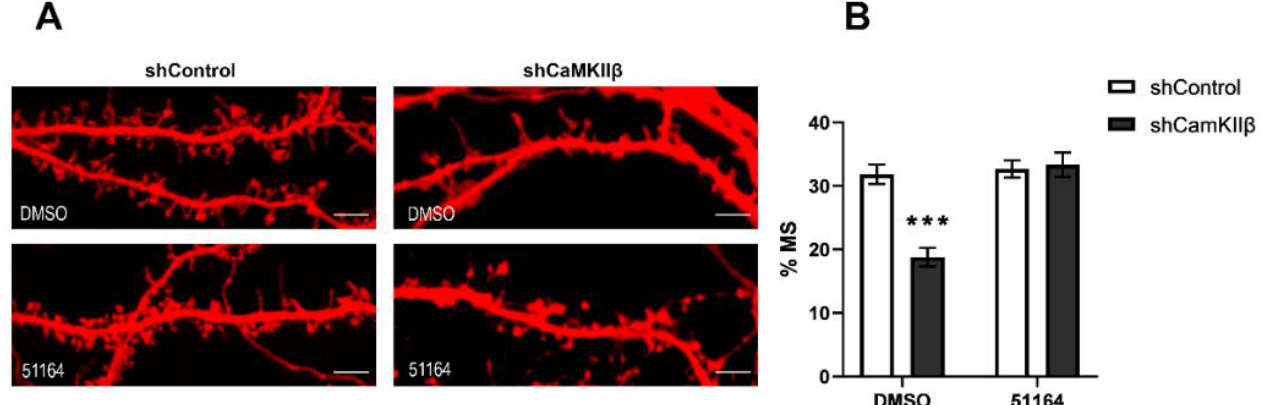
Figure 2. 51164 rescues mushroom spine loss in hippocampal neurons with CaMKIIβ knockdown. ( A ) Representative confocal images of dendritic spines in control neurons (shControl, co-transfected with cherry, and shControl plasmids) and in neurons with CaMKIIβ knockdown (shCaMKIIβ, co - transfected with cherry and shCaMKIIβ plasmids). The results are shown for the control conditions (DMSO) and neurons treated with 100 nM 51164 for 24 hours (51164). Scale bar = 8 µm. ( B ) Bar chart of mean percentages of mushroom spines (% MS). Results are presented as the mean ± SEM, n (neu- rons) = 7 – 10 per group from one experiment, the experiment was repeated twice. Normal distribu- tion was checked by the Shapiro – Wilk test. Statistical analysis was performed using two-way ANOVA following Sidak’s multiple comparisons test, *** p < 0.0001.